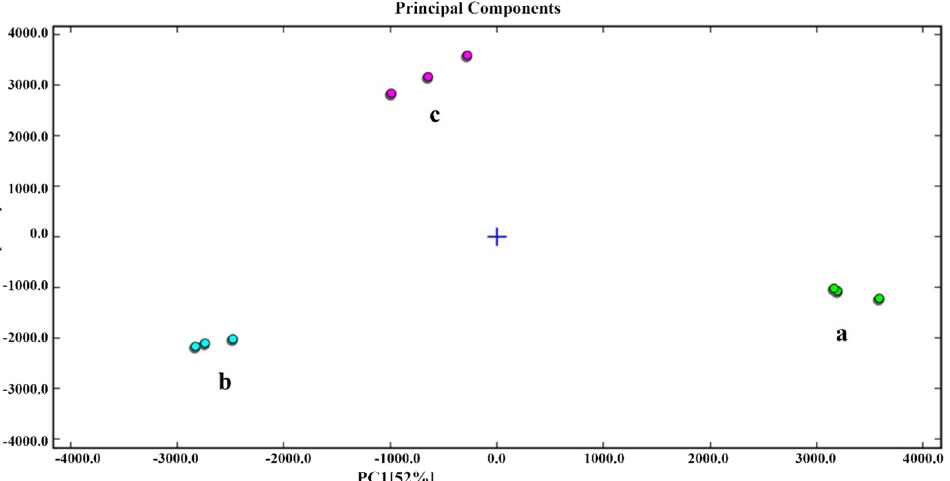
Figure 6: PCA plot of VOCs in avocado oil obtained with the di ff erent extraction methods: ( a ) squeezing extracted; ( b ) supercritical carbon dioxide extracted; ( c ) aqueous